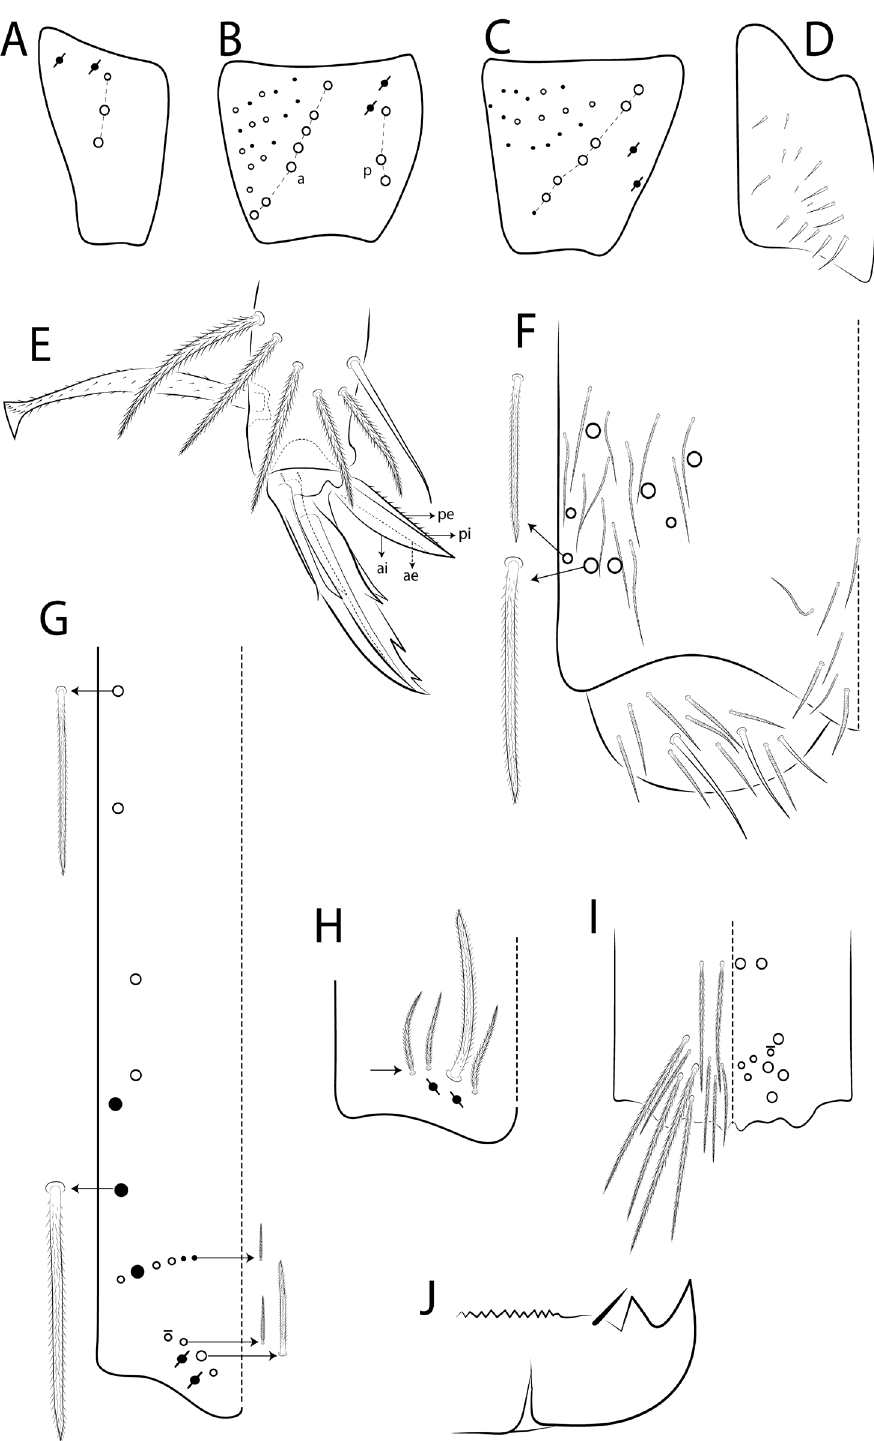
Fig. 7. Willowsia nigromaculata (Lubbock, 1873). A . Subcoxa I. B . Subcoxa II. C . Subcoxa III (lateral view). D . Trochanteral organ. E . Distal tibiotarsus and empodial complex III (posterior view). F . Collophore chaetotaxy (lateral view). G . Manubrium dorsal chaetotaxy. H . Manubrial plate. I . Subapical and apical chaetotaxy of ventral manubrium. J . Mucro (lateral view). Abbreviations: see Material and